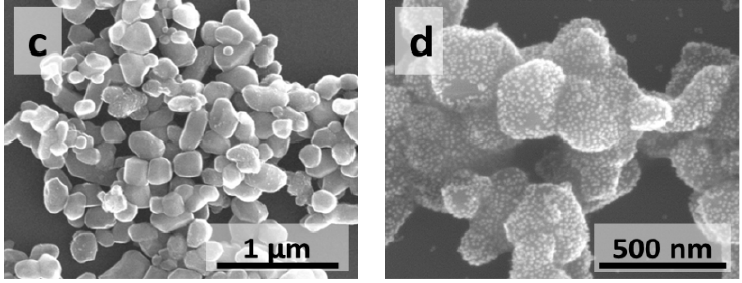
Figure 2. Scanning Electron Microscopy (SEM) images of silicon dioxide and titanium dioxide